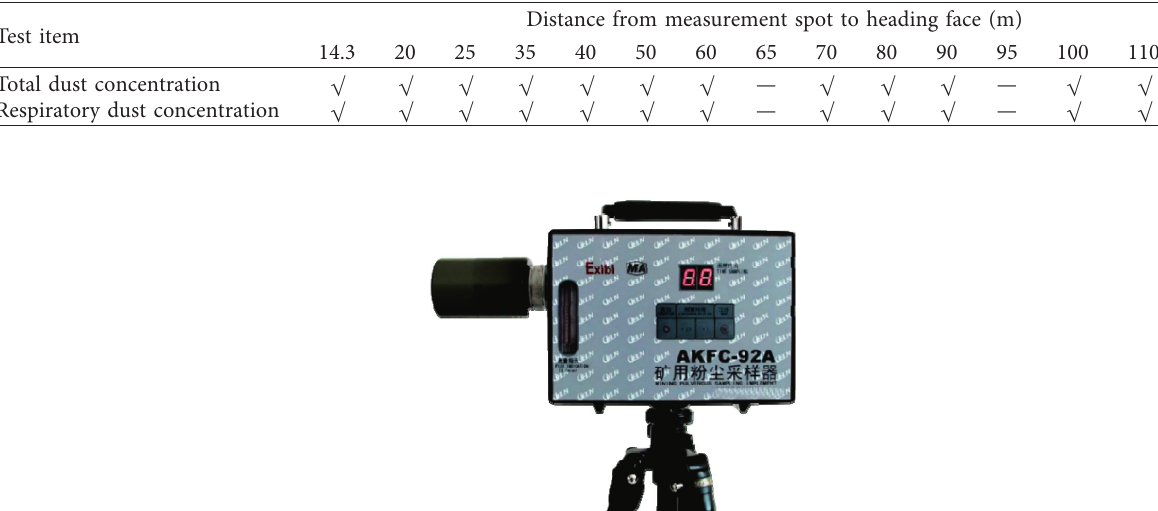
Table 2: Arrangement of measuring spots.